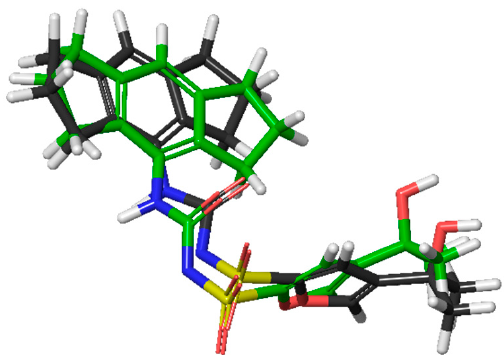
Figure 1. In grey, the MCC950 optimized in DFT, and in green, the same molecule optimized with EpiK (oxygen atoms are displayed in red, hydrogens in white, sulfurs in yellow and nitrogen in blue).